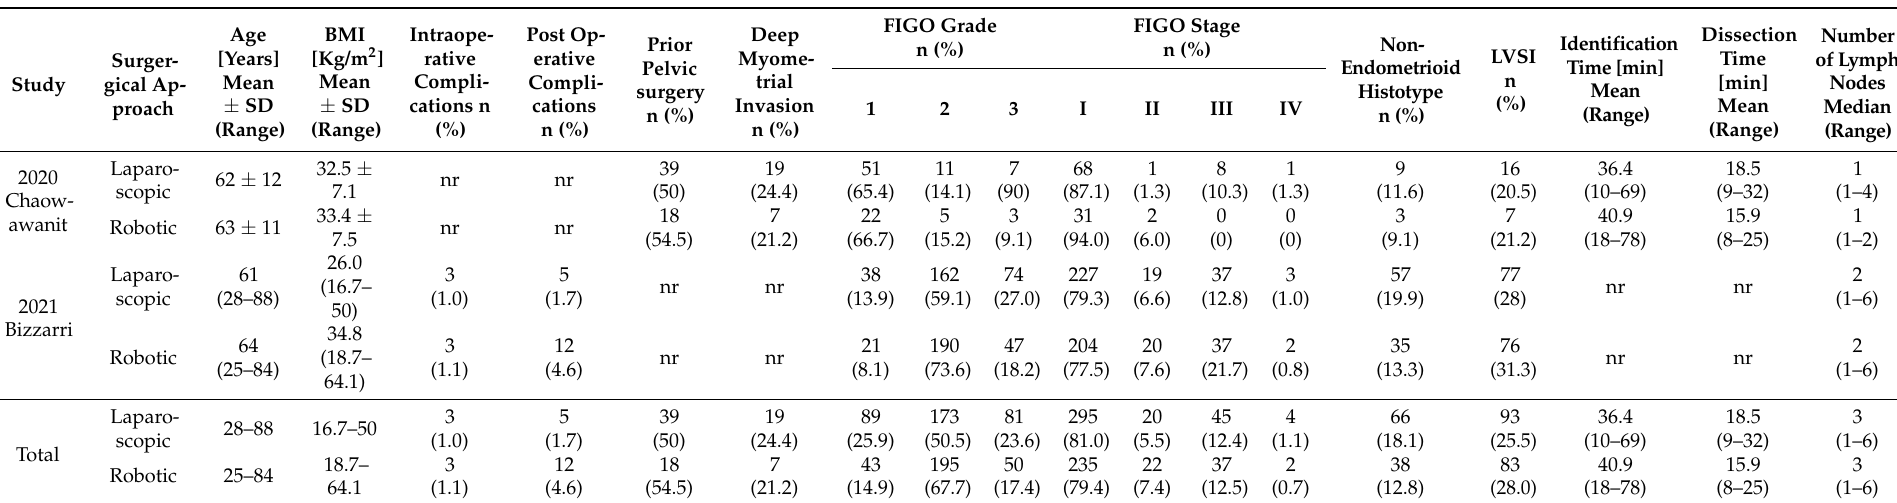
Table 2. Patients’ characteristics.